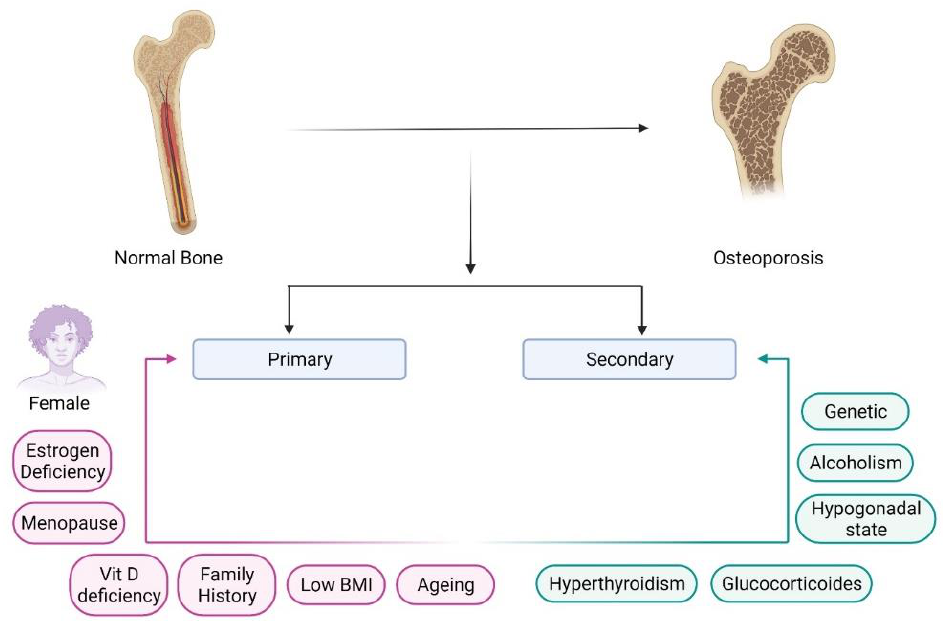
Figure 1. Primary and secondary causes of the development of osteoporosis. This image represents diverse causes of the transformation of normal bone towards osteoporosis. Primary causes include various factors within the body, and secondary causes have different pathological conditions. “Image created with BioRender.com ”